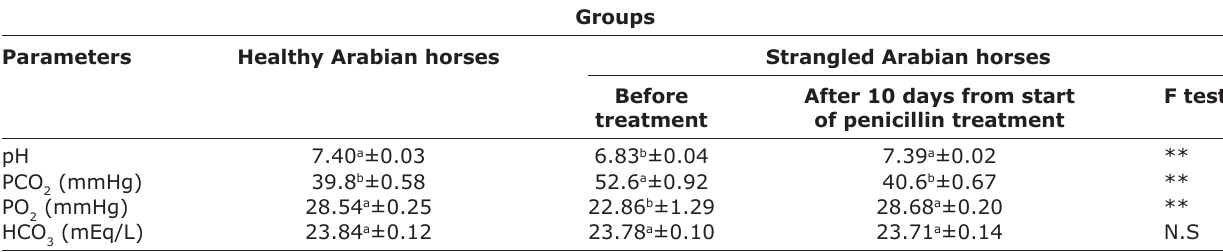
Table-5: Blood gasses and acid-base balance in Arabian horses naturally infected with S. equi during the disease after 10 days from penicillin treatment compared with the healthy horses (mean values±SE).